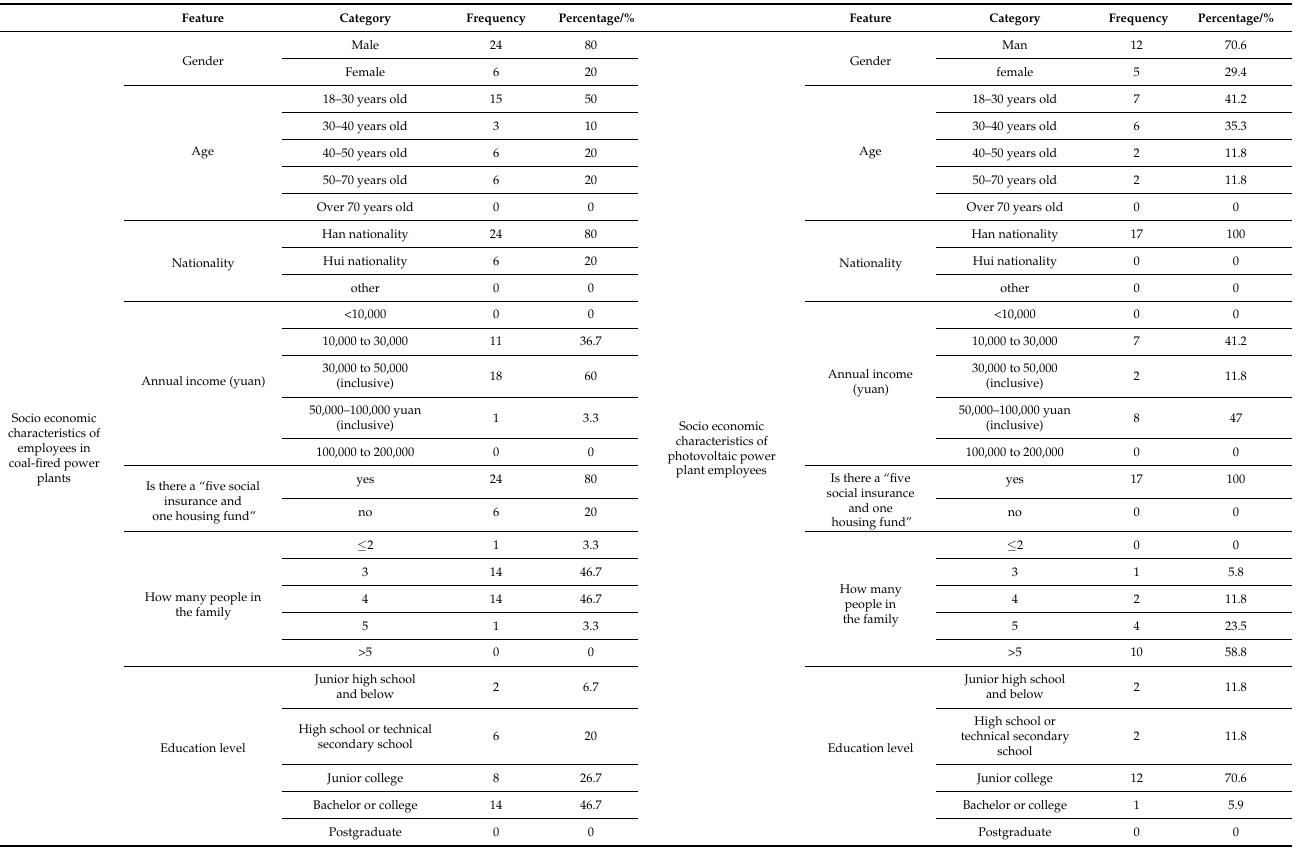
Table 8. Basic social and economic characteristics of employees in coal-fired power plants and photovoltaic power